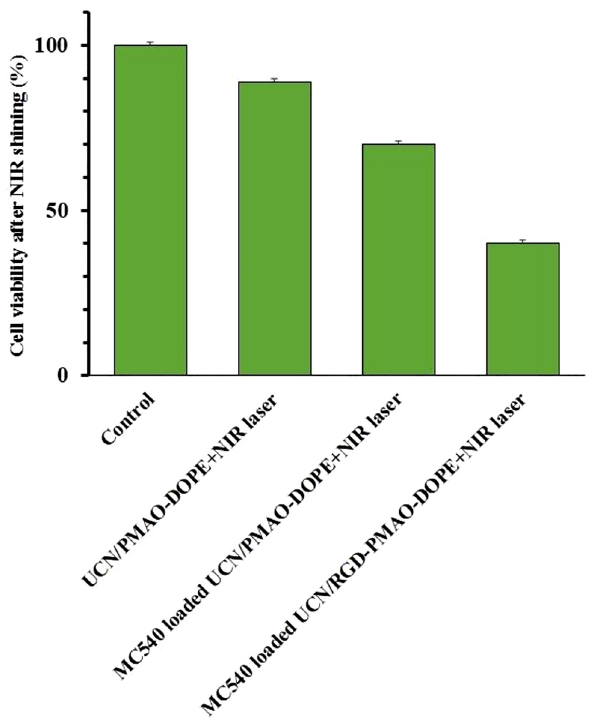
Figure 10: PDT treatment efficiency on MCF-7 cells. Untreated cells as control group and cells treated with UCN/PMAO-DOPE NPs, MC540 loaded UCN/PMAO-DOPE NPs or MC540 loaded UCN/ RGD-PMAO-DOPE NPs after NIR laser irradiation (980 nm, 30 min). Adapted from Wang et al.